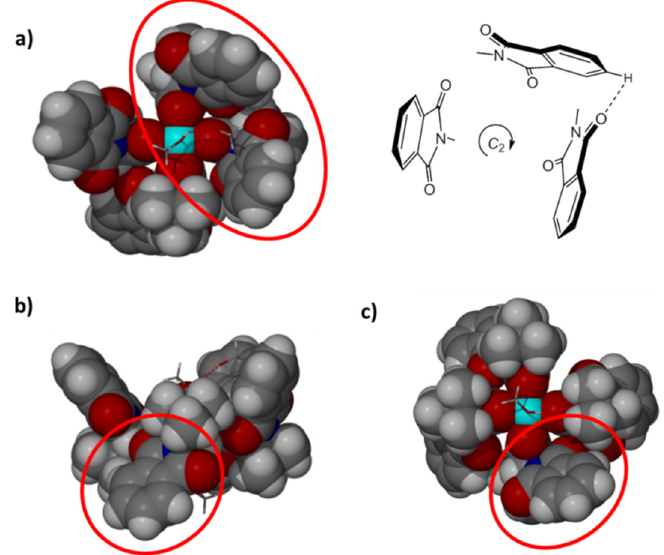
Figure 4. Space filling and schematic representations of the partial crown shaped chiral cavity of [Rh 2 ( S , S , S , R ‐ PTTL) 4 (MeOH) 2 ].MeOH.H 2 O viewed along the Rh ‐ Rh bond ( a ) onto the cavity and ( c ) from the opposite side of the cavity. ( b ) A side view into the equatorial plane of the Rh centres to highlight the R ‐ amino acid derived ligand which does not form part of the partial cavity. Rh bound MeOH and lattice MeOH/water molecules are depicted in stick form (hydroxyl groups of the Lewis bases were only located if Rh bound and the extended hydrogen bonded structure is not shown beyond the asymmetric unit).